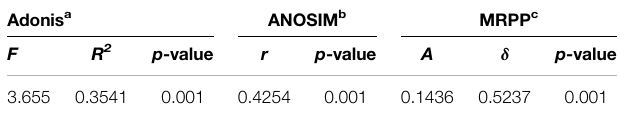
TABLE 1 | Signi fi cance tests of the impacts of microplastic concentration on the nematode community composition in top-layer soils with three non- parametric statistical analyses ( n = 6).